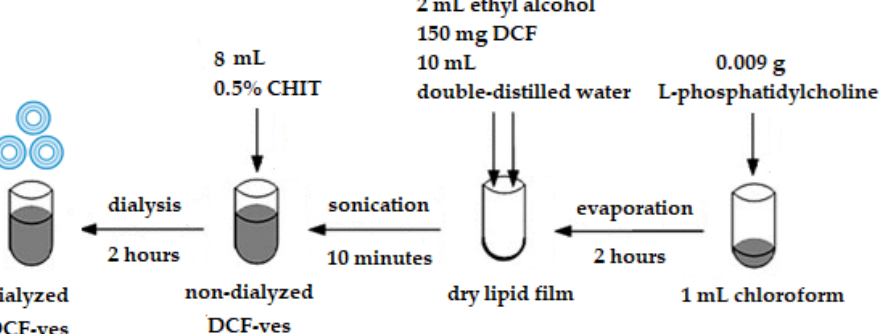
Figure 1. The procedure for obtaining chitosan-stabilized lipid vesicles with